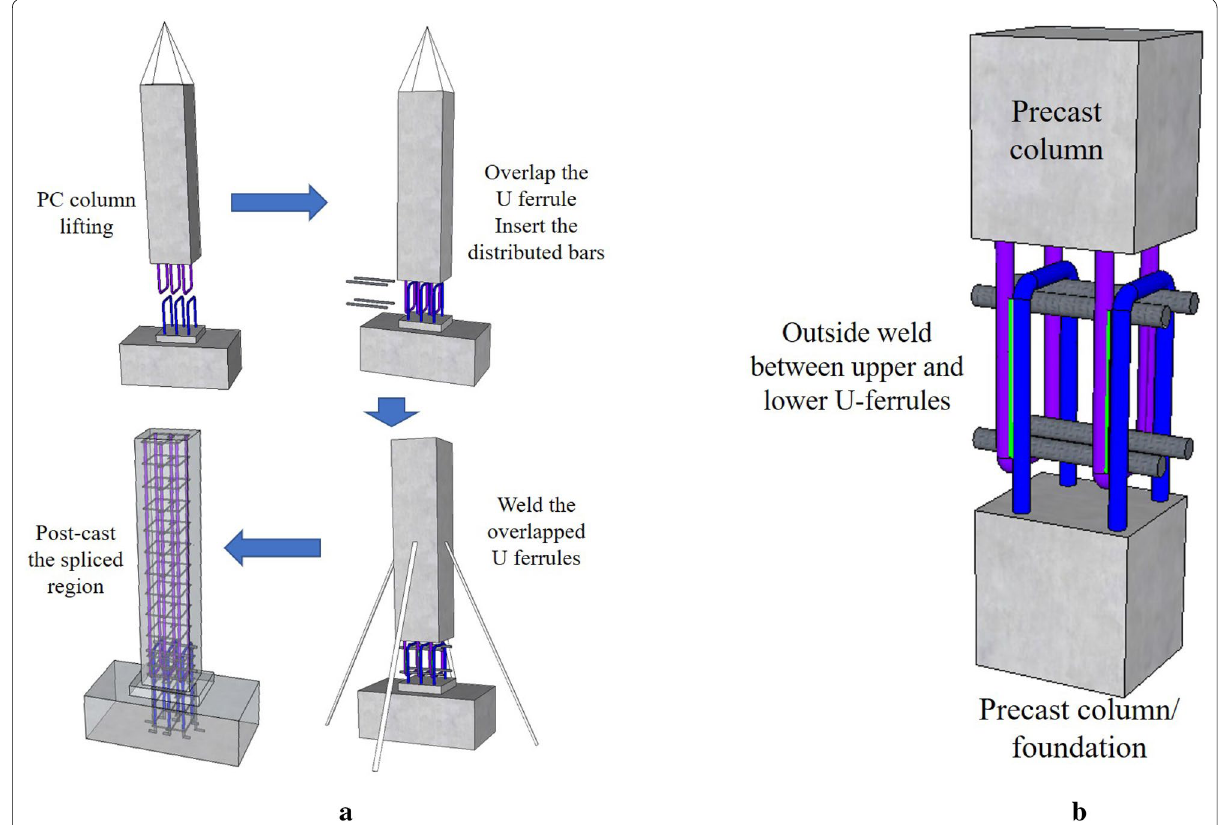
Fig. 2 Construction detail and working process of the modified URF connection: a the modified URF connection; b construction process of the modified URF